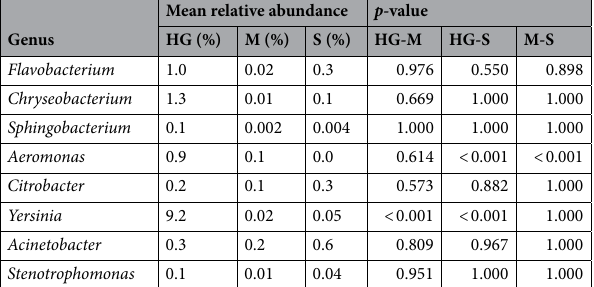
Table 1. Mean relative abundance and level of significance of potentially pathogenic bacterial genera in the fire salamander gut microbiome between different forests (HG = forest Heilig Geestgoed, M = forest Makegem and S = forest